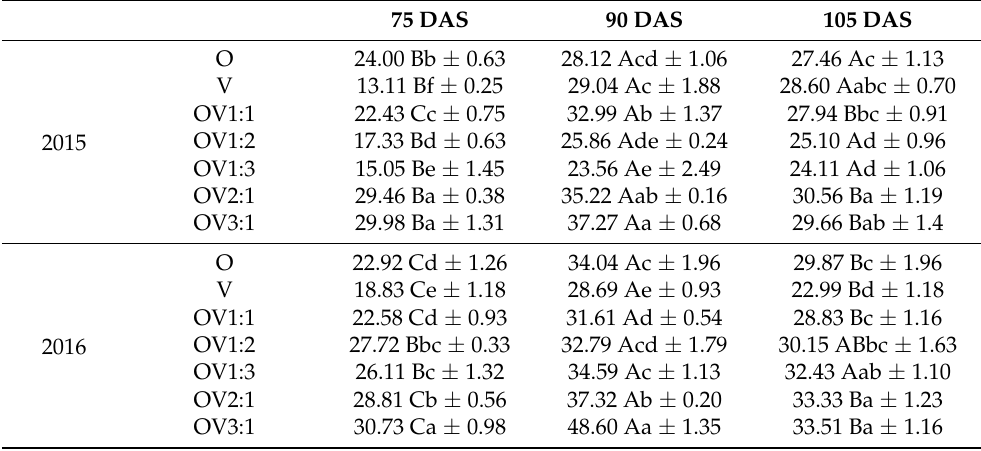
Table 3. The effect of different intercropping ratios of oat and common vetch on fresh grass yield (t · hm − 2